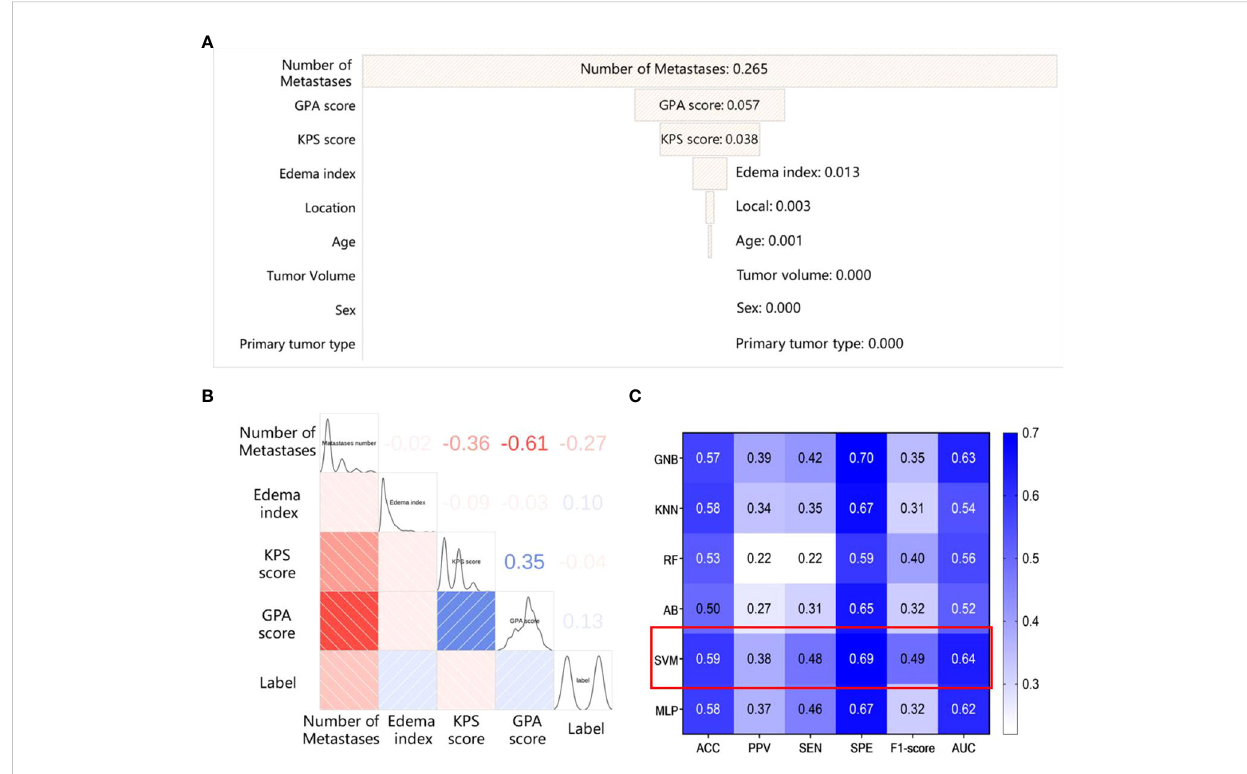
FIGURE 2 The results of the model based on clinical features (A) The importance of the clinical features; (B) The spearman correlation coef fi cient matrix between the selected clinical features; (C) The performance of different classi fi ers based on clinical